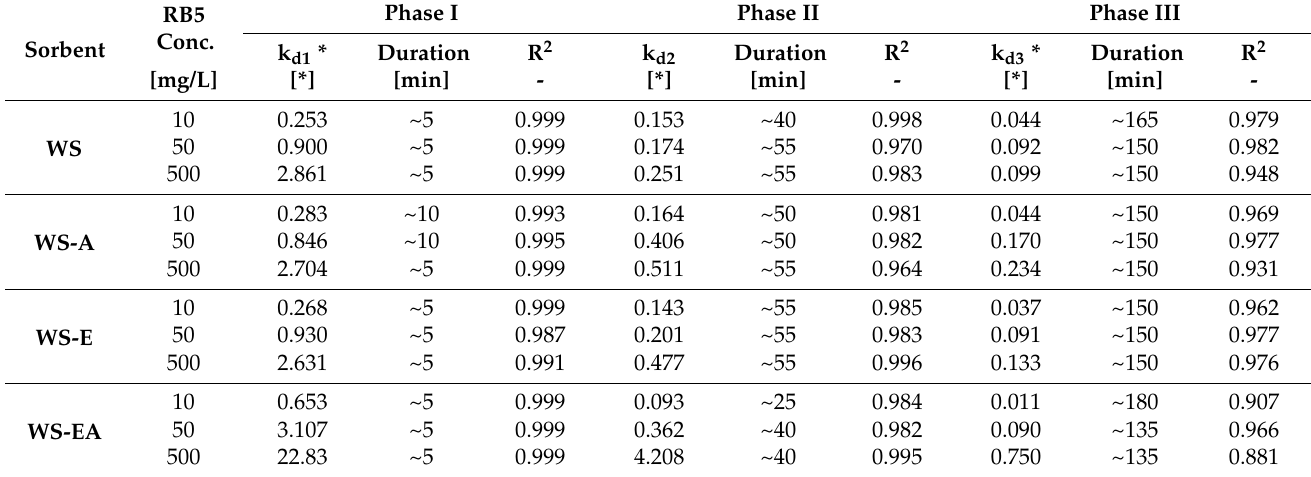
Table 4. RB5 dye diffusion rate constants determined from a simplified intramolecular diffusion model. * [mg/(g · min 0.5